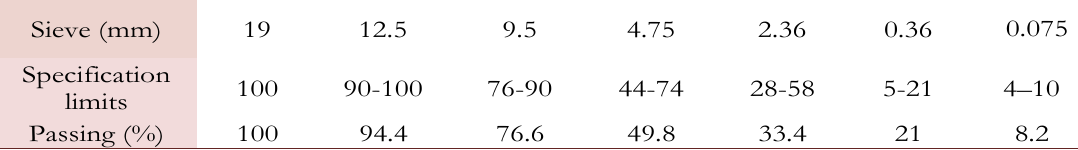
Table 2: Grading of the aggregates used in this study.